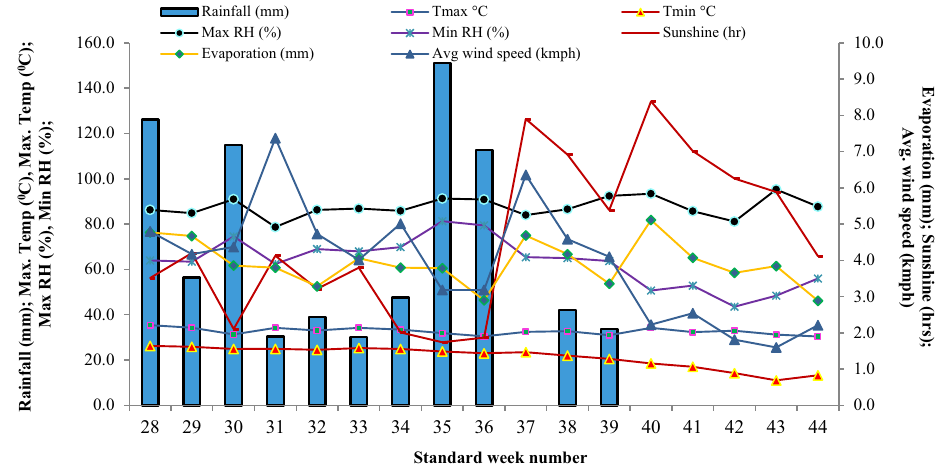
Figure 10. Weekly weather conditions during the cropping period of Kharif season maize in the Indo-Gangetic Plains, 2018.